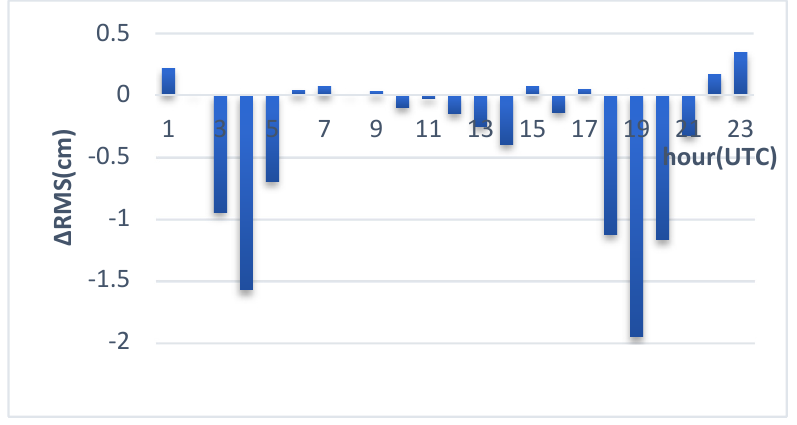
Figure 10. The difference of RMS 5° computed by w-TMFabc minus w-WHU-SMFabc_gg for station SHAO (Shanghai, China) for doy 202, 2018.